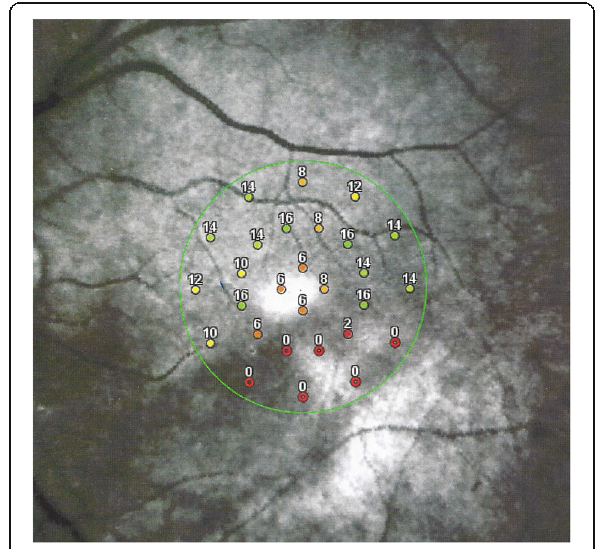
perimetry and who immediately referred the patient.